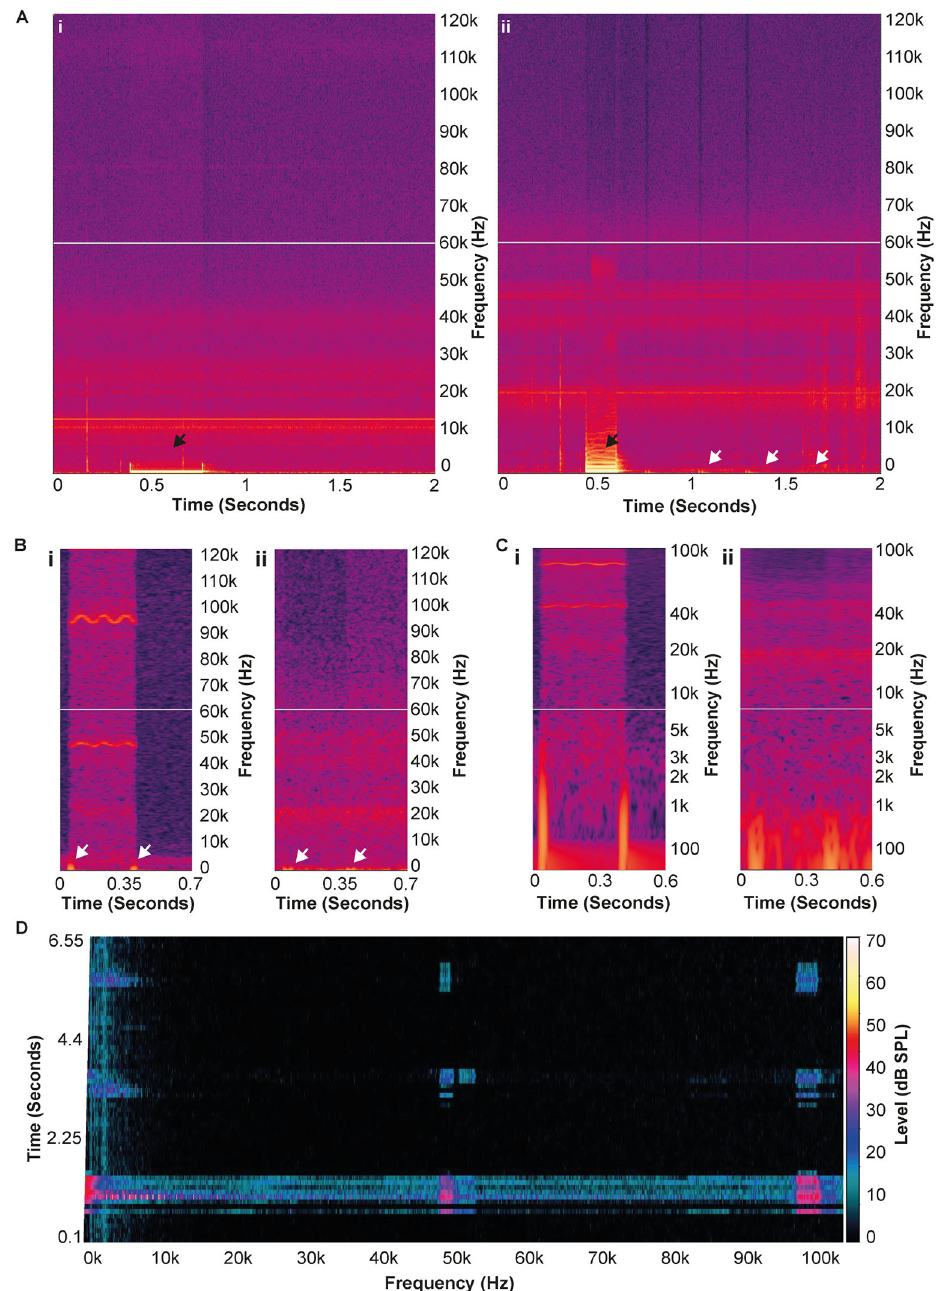
Figure 3. The walkie-talkie noise was likely radio frequencies (RF) interference. A) Spectrograms of the AudioMoth recordings of the radio being used in an isolated room (i), and in close proximity to an active monitor speaker (ii). The black arrows denote the audible beep produced when the transmit button was pressed. The white arrowsin(ii)showtheRFinterferencepickedupbytheactivemonitorspeaker,whiletheabsenceofthesein(i)shows that the noise did not arise from the walkie-talkie alone. B) Comparison of the spectrograms from the Avisoft recording(i)andtheAudioMothrecording oftheradiobythespeaker(ii).Thewhitearrowsagaindenotetheaudible clicks in both recordings, which are not produced by the walkie-talkie itself (as shown in [Ai]); note the ultrasonic noise picked up the Avisoft system are bordered by these clicks. C) The same comparison as (B) using a logarithmic frequency scaleto highlightthe temporal similarities between the noise from the Avisoft system and the radio being operated in close proximity to the speaker. D) FFT spectrogram using the PULSE software to analyse the recording made by the Avisoft system. Noise can clearly be seen at the same frequencies that were originally detected by the Avisoft system, indicating that if the noise was not an artefact, the PULSE system would have also detected it.